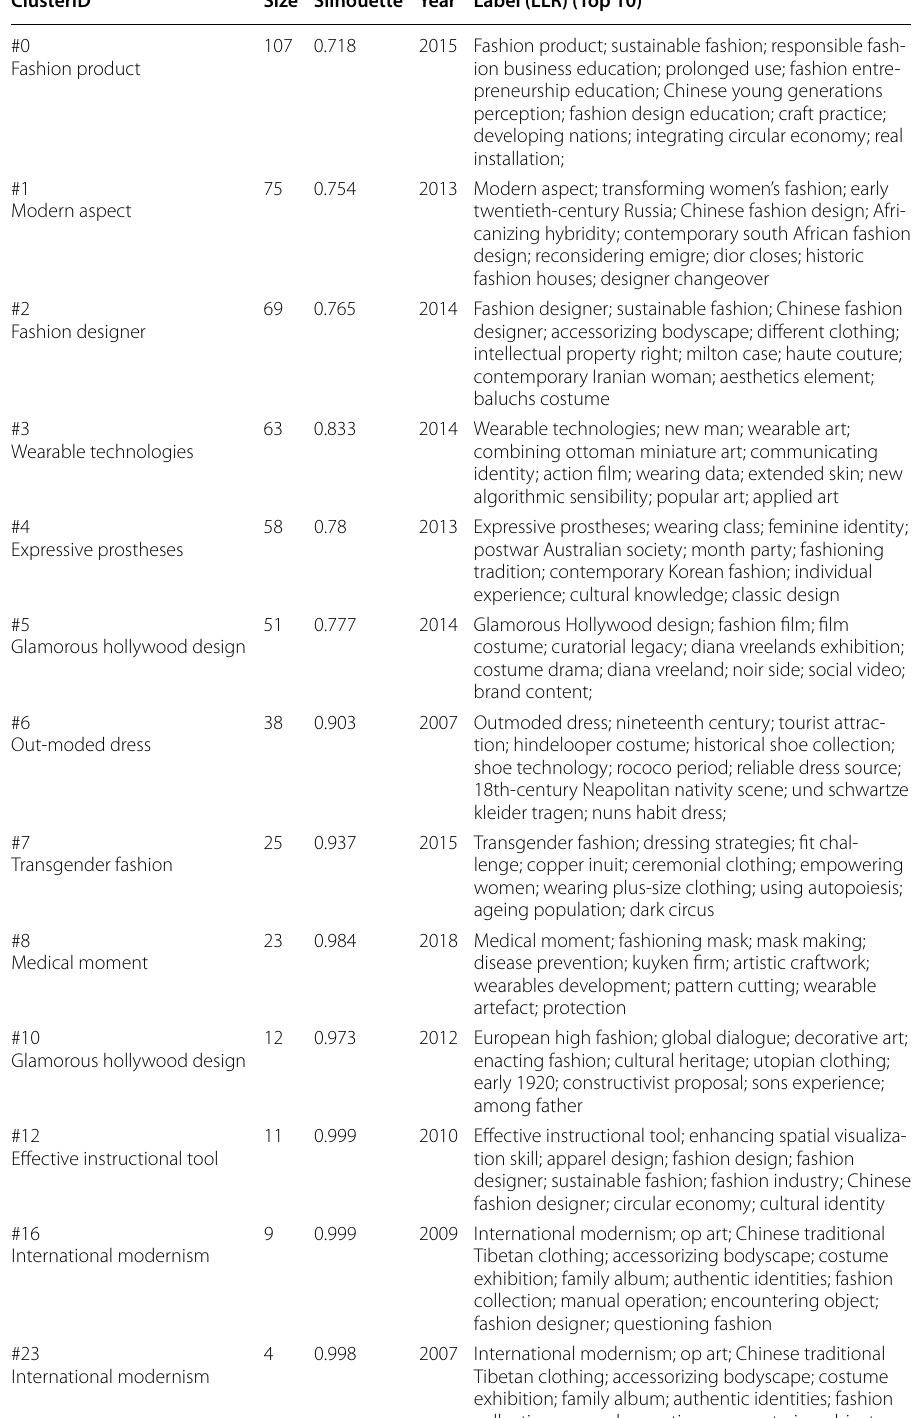
Table 5 The top 10 keywords in the respective cluster